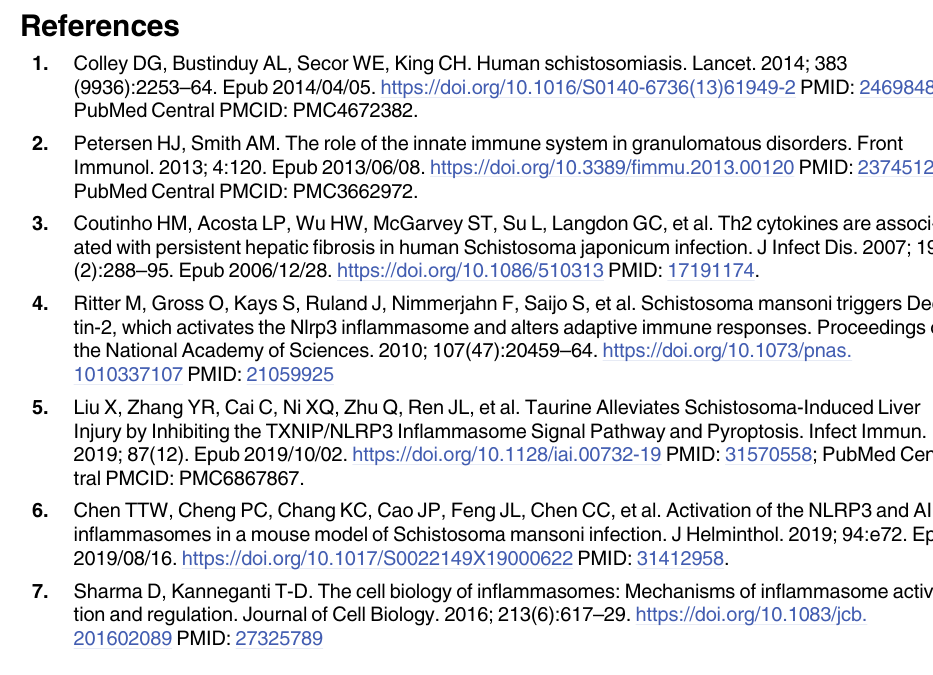
sections of the mice. Collagen were stained as blue which was encircled by a yellow dotted line. (F) Ishak fibrosis scoring based on Masson’s trichrome staining. For quantification in (C and E), the number and the corresponding areas of each circled area were potted directly on the graph. Each dot represents one fibrotic or positively stained area. Quantification or scoring was performed on three slides in each group. 15 random microscopic fields were examined on each slide. Images are shown at 100 × magnifications and scale bars correspond to 200 μ m. � P - value < 0.05, �� P -value < 0.01, ��� P -value < 0.001, and ���� P -value < 0.0001 compared with control group; # P -value < 0.05 and # P -value < 0.01 compared with infected group. (TIF) S1 Table. Primer pairs used in this study.